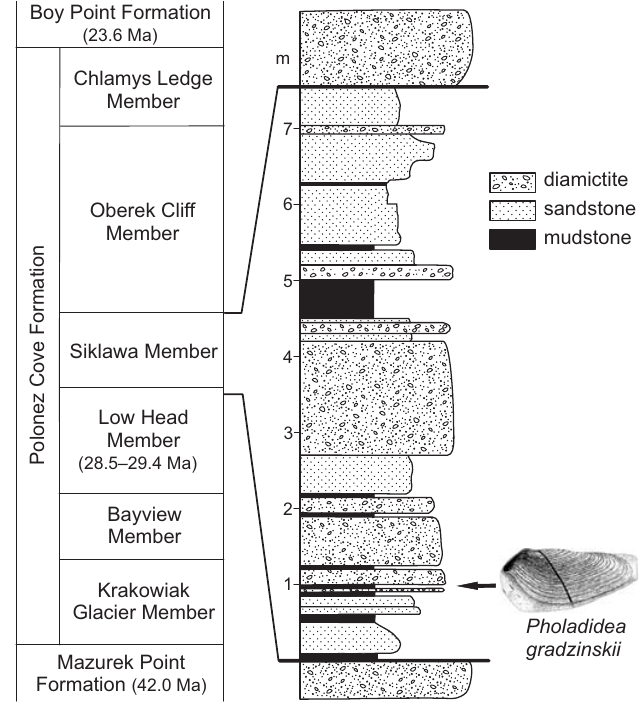
Fig. 2. Simplified lithostratigraphic profile of the Polonez Cove Formation, with lithological profile of the Siklawa Member at Mazurek Point where investigated fossils were collected. The arrow marks the mudstone interval where the majority of the specimens of Pholadidea gradzinskii sp. nov. de- scribed in this paper was collected. The lithostratigraphy after Birkenmajer (1983), Por ę bski and Gradzi ń ski (1987), Birkenmajer (2001), Troedson and Smellie (2002). Dating of the units after Smellie et al. (1984), Birkenmajer (1989), Dingle et al. (1997), Dingle and Lavelle (1998), and Troedson and Smellie (2002). The lithological profile of the Siklawa Member at Mazurek Point partially adapted from Ga ź dzicki et al.